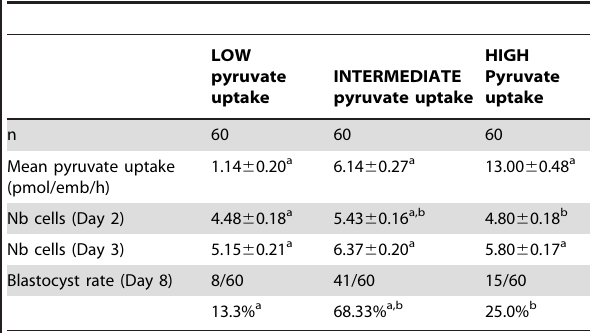
Table 3. Rate of blastocyst development according to the level of pyruvate uptake measured between day 2 and day 3.